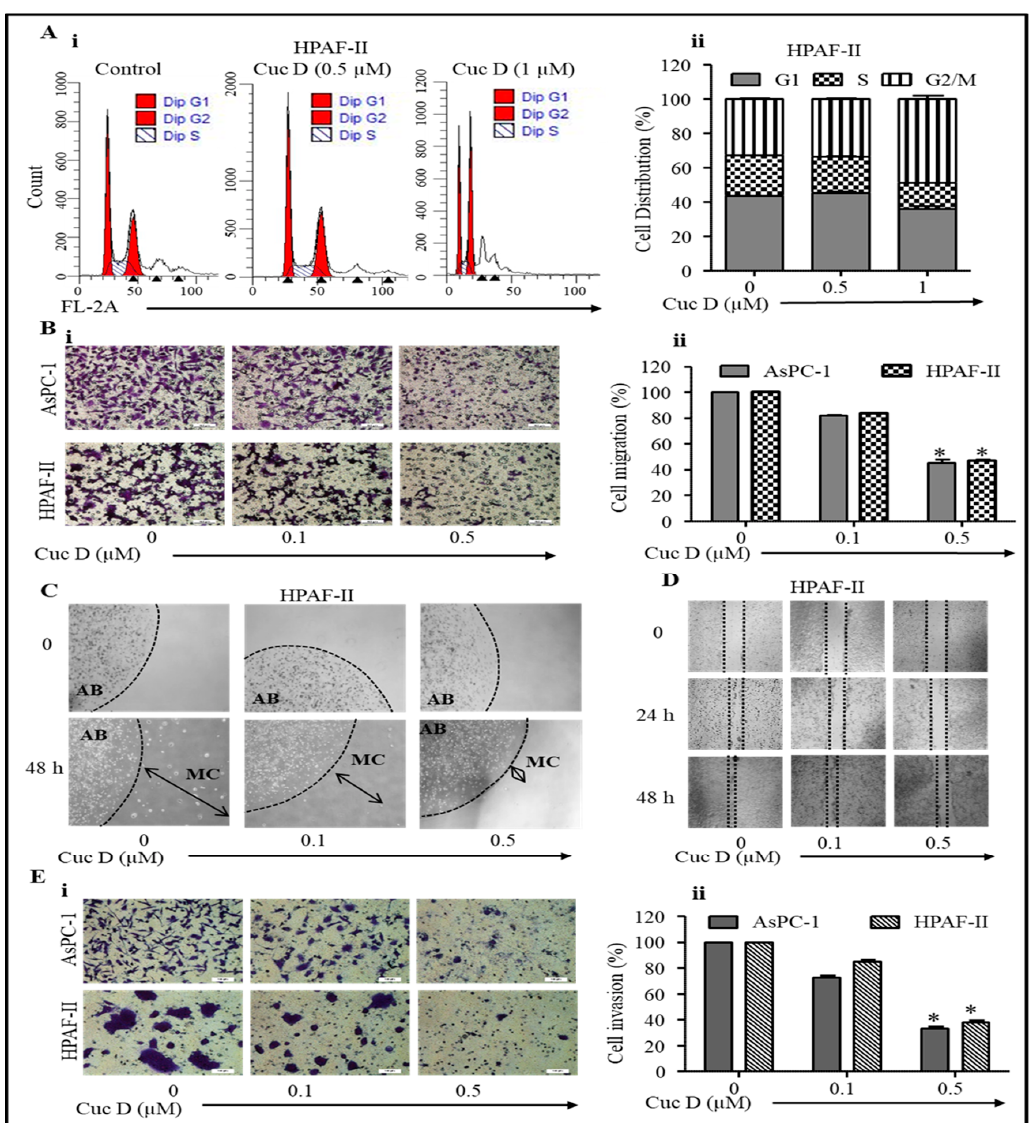
Figure 2. Cuc D arrest cell cycle progression, decreases migration and invasion of pancreatic cancer cells. ( A ) E ff ect of Cuc D on cell cycle distribution of HPAF-II cells as determined by flow cytometry. ( B–D ) E ff ect of Cuc D on cell migration of PanCa cells as determined by Boyden chamber assay ( B )